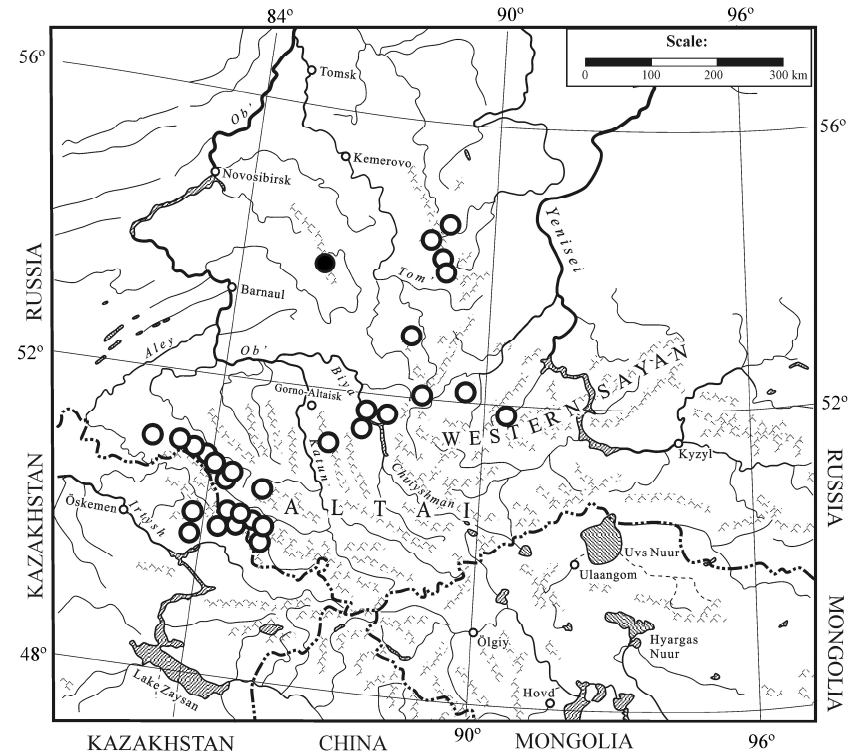
Figure 3. Distribution of Apterocuris sibirica in the mountains of South Siberia and East Kazakhstan. White circles—known localities, black circle— locus typicus .